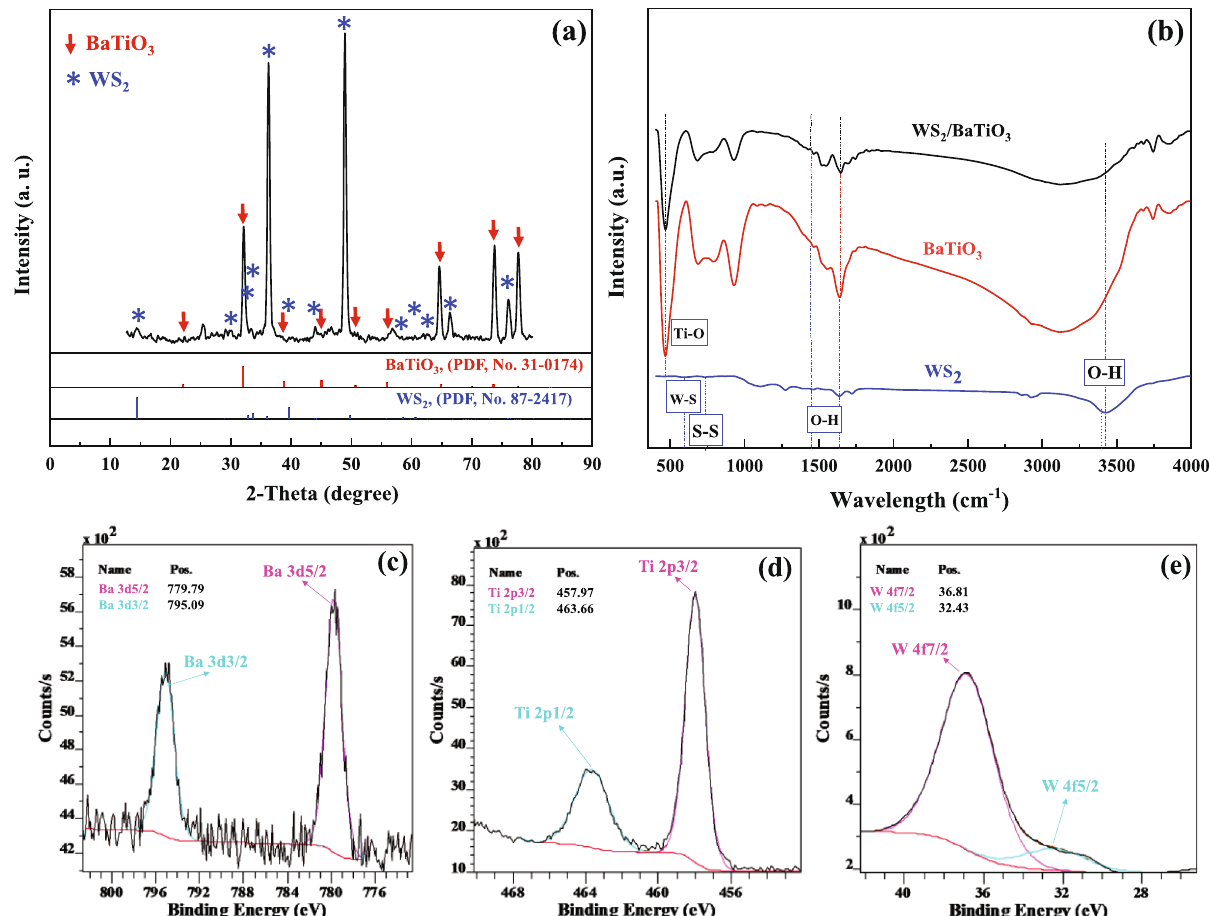
Fig. 1 Structural characterization of the so-synthesized materials. a The XRD and b FT-IR spectra of the pure BaTiO 3 , WS 2 , and BaTiO 3 /WS 2 . High- resolution XPS spectra of c Ba 3d, d Ti 2p, and e W 4 f of BaTiO 3 /WS 2